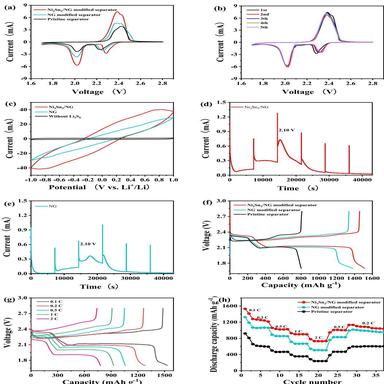
(a) CV curves of the batteries with different separators at a scan rate of 0.1 mV s1 . (b) CV curves of the battery with Ni3Sn2/NG modified separator. (c) CV curves of symmetric batteries with Ni3Sn2/NG, and NG electrodes in 0.25 M Li2S6 at 1 mV s1 . PITT measurements of Li | Li2S8 cells with (d)Ni3Sn2/NG and (e)NG, the cells were discharged from 2.14 to 2.04 V with a step of 0.02 V. (f) Charge/discharge curves of the batteries with different separators at 0.1 C. (g) First charge/discharge curves of the bat